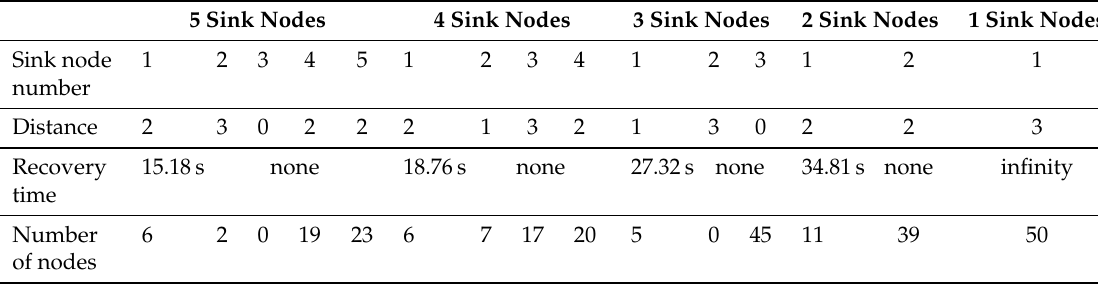
Table 5. Fault-tolerance and